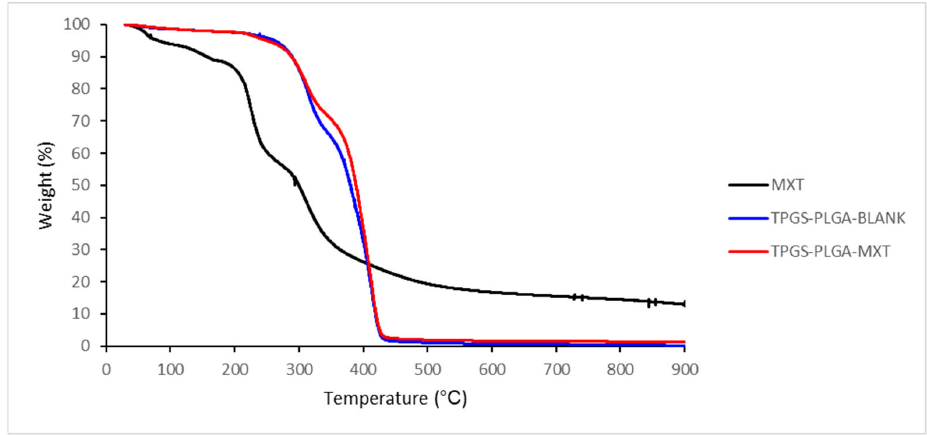
Figure 5. TGA curves of the methotrexate ‐ loaded in polymeric TPGS ‐ PLGA